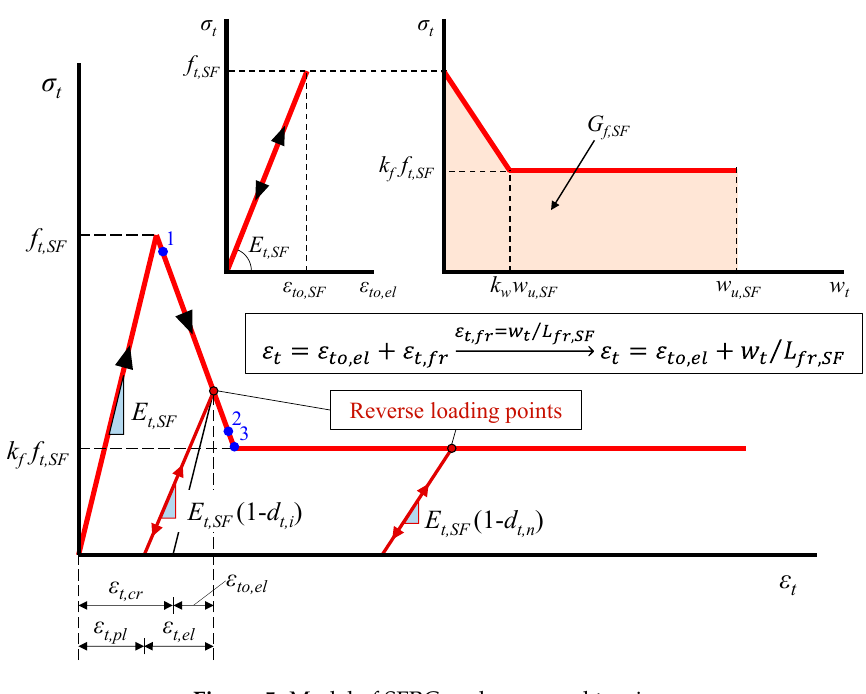
Figure 5. Model of SFRC under reversal tension.